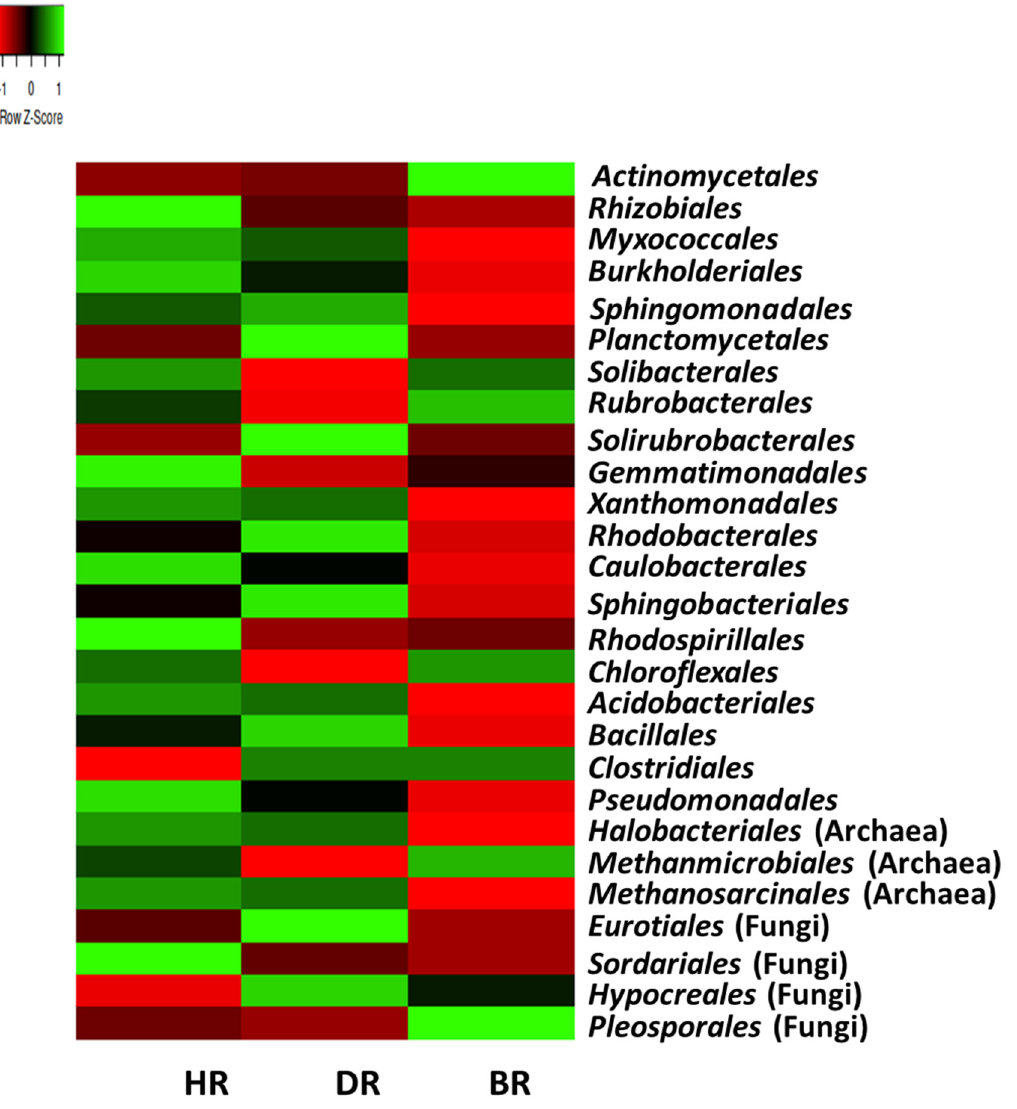
Figure 4. The order heatmap of soil microorganisms affiliated with the tomato plants. Each plot with unique color functioned as a saturation gradient employing the mean value with a z-score. HR = rhizosphere soil of healthy tomato plant; DR = rhizosphere soil of diseased tomato plant; and BR = bulk soil obtained from the soil without tomato plantation.